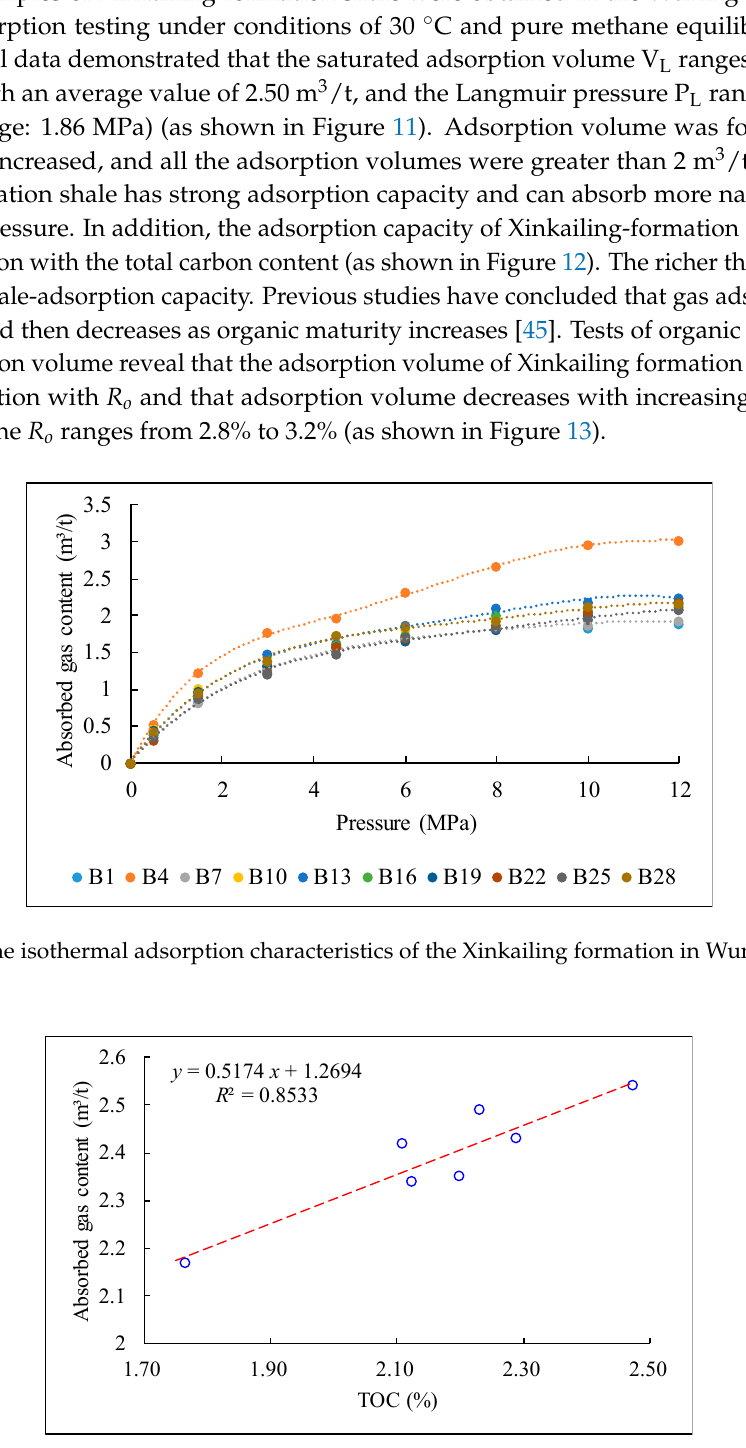
Figure 12. Positive relationship between total organic carbon (TOC) content and adsorbed gas content of Xinkailing shale.